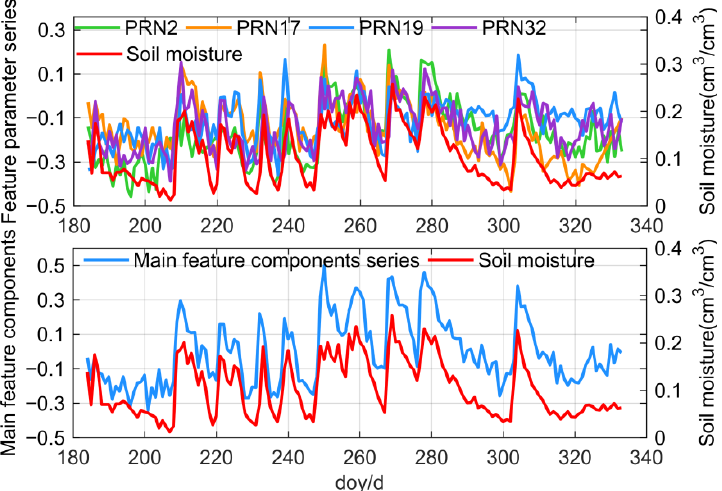
Figure 5. Clustering results using station P043.